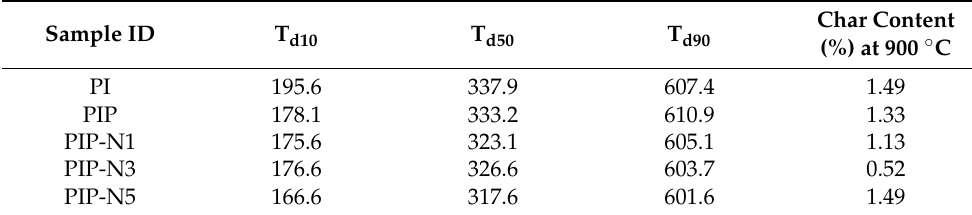
Figure 7. ( A ) TGA curves and ( B ) DTG curves of PVA, inulin, β -CD, and niaouli essential oil.